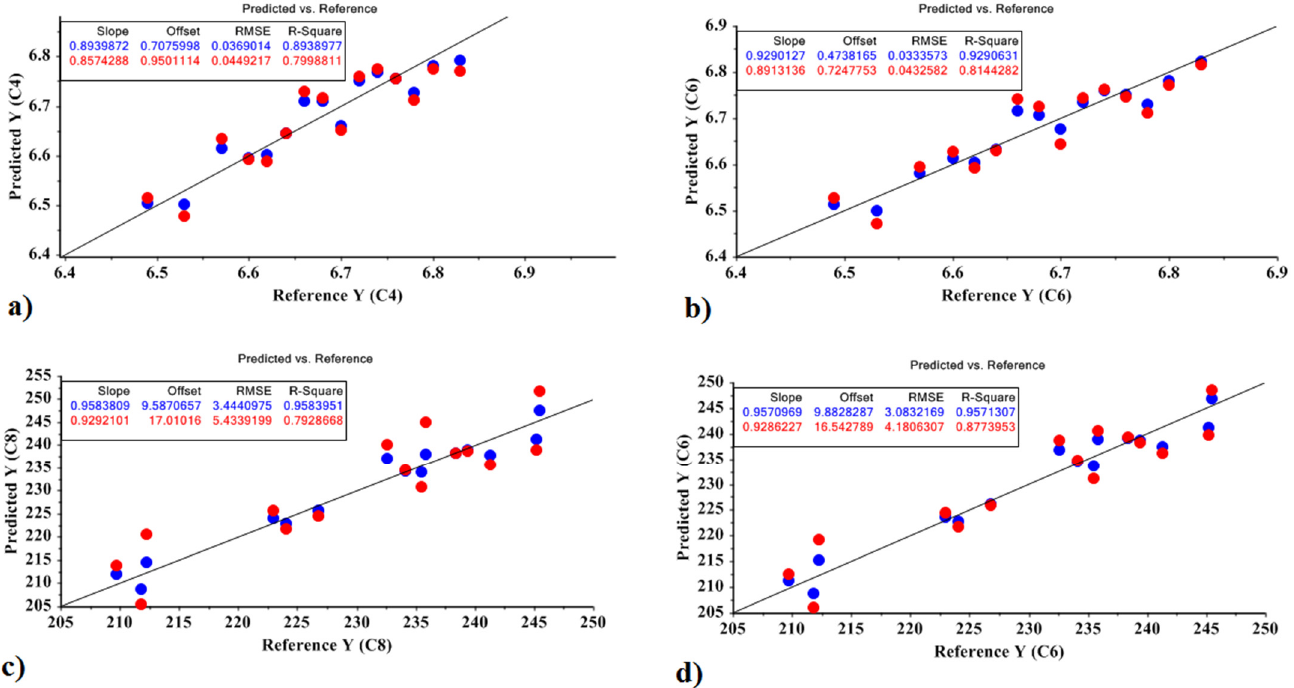
Figure 5. MLR prediction models for predicting the amount of carbohydrate and sugar in the Jelly cultivar; ( a ) amount of sugar based on PCR method, ( b ) amount of sugar based on PLSR method, ( c ) amount of carbohydrate based on PCR method, ( d ) amount of carbohydrate based on PLSR method.